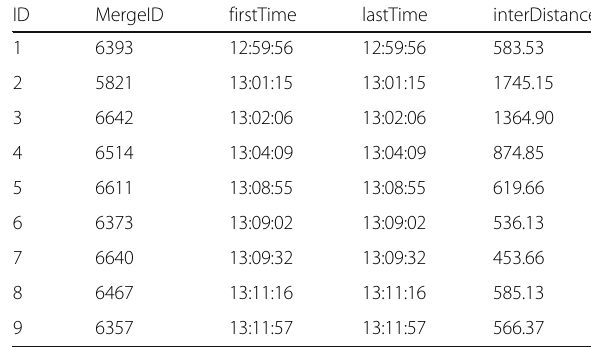
Table 6 Trajectory records of one